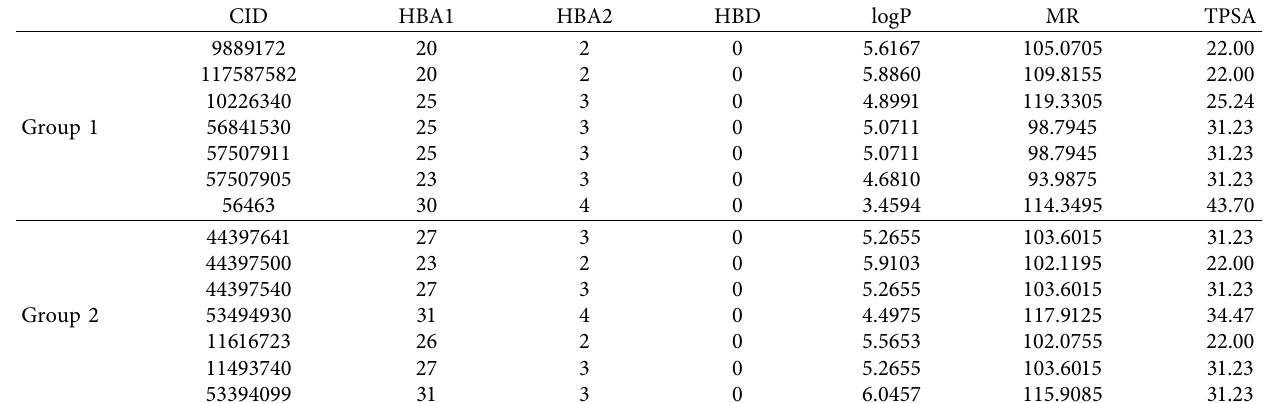
Table 2: Molecules’